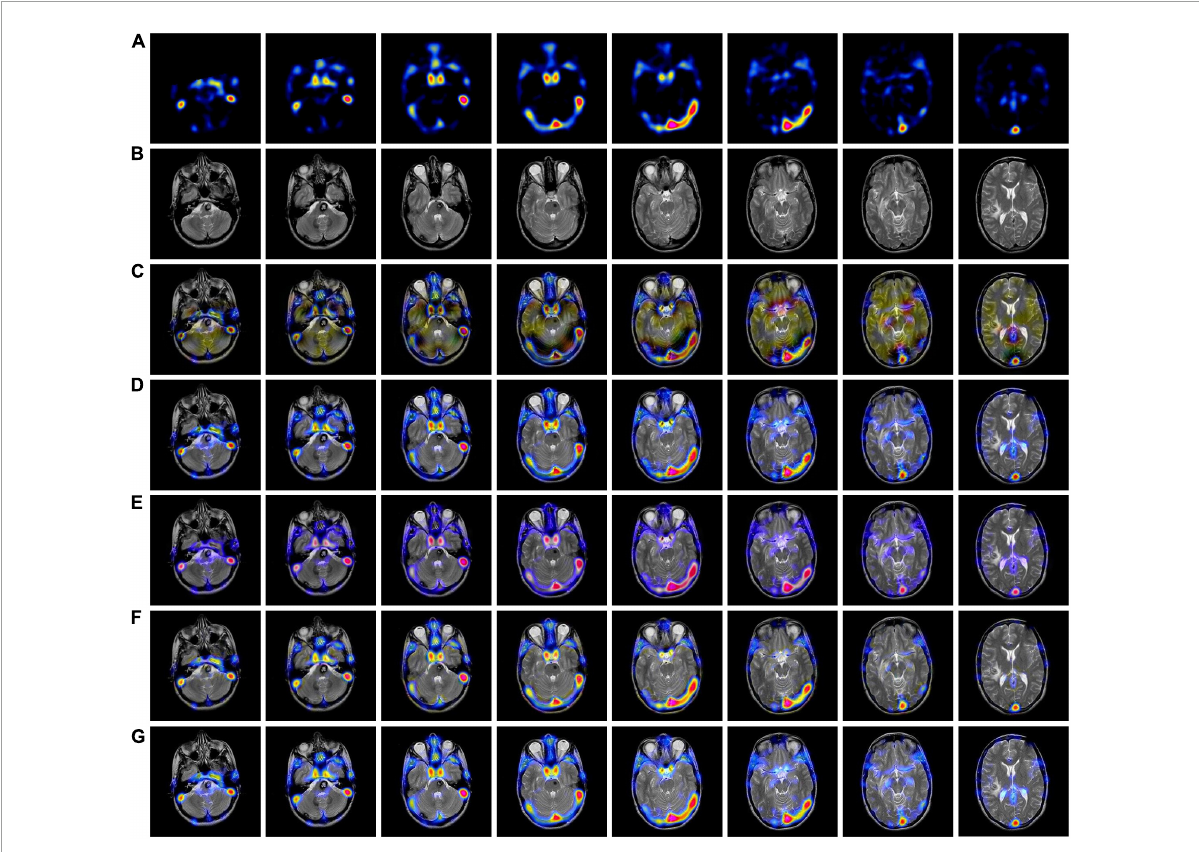
FIGURE6 MRI-SPECT fusion images of the five methods in Paras1. (A) Single photon emission computed tomography (SPECT) source image; (B) magnetic resonance imaging (MRI) source image; (C) nonsubsampled contourlet (NSCT) fusion result; (D) non-subsampled shear wave transform (NSST) fusion result; (E) guided filter ng fusion (GFF) fusion result; (F) Laplacian redecomposition (ReLP) fusion result; (G) fusion result of the proposed